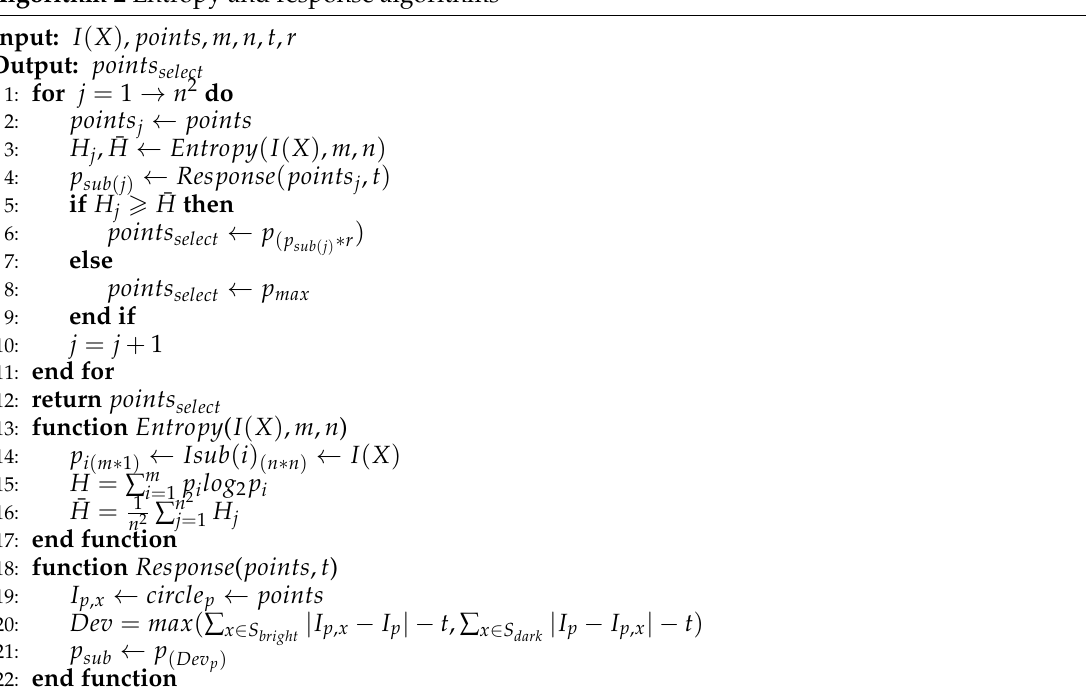
Algorithm 2 Entropy and response